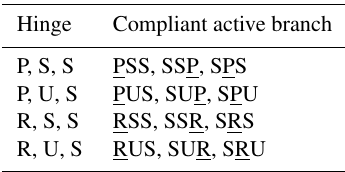
Table 1. Some types of the compliant active